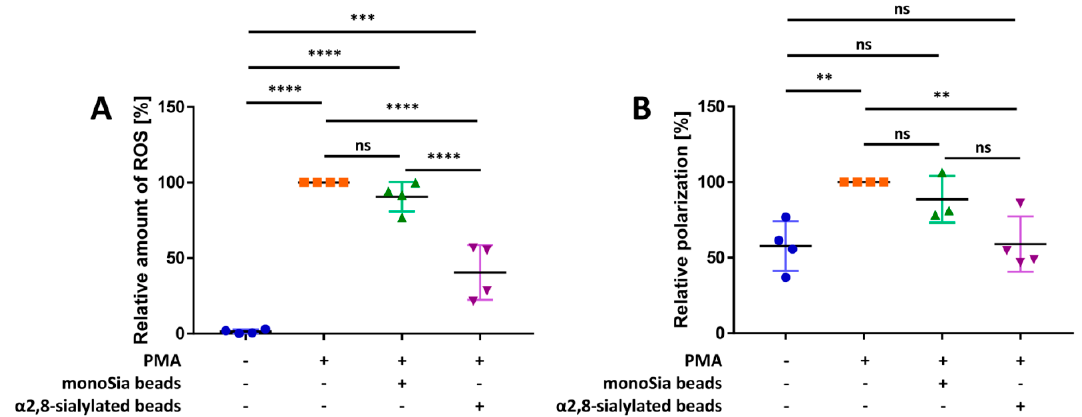
Figure 1. α 2,8-sialylated particles reduce the production of ROS and the depolarization of the membrane when neutrophils are stimulated with PMA. ( A ) Scatter plot of the relative amount of ROS (%) produced after 30 min of stimulation with PMA. The determination of the relative amount of ROS (%) was performed using DHR. The values for PMA-treated cells were set to 100%. Four independent experiments were performed. ( B ) Scatter plot of the polarization status of the membrane. Determination of membrane depolarization was performed using DiBAC 4 . The emitted fluorescence of the PMA-induced cells was set to 100%. Mean values ( n ≥ 3) and standard deviations are displayed in the diagrams. ANOVA and a multiple-comparison Tukey test were applied. Statistically significant differences are given as follows: ns, not significant, ** p ≤ 0.01; *** p ≤ 0.001; and **** p ≤ 0.0001.